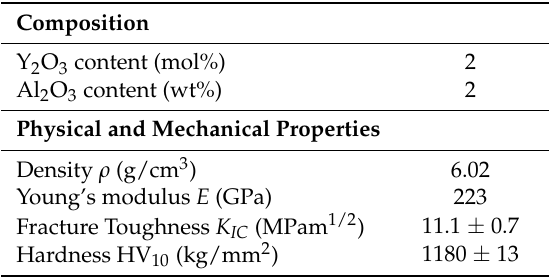
Table 1. Chemical composition and mechanical properties of the workpiece